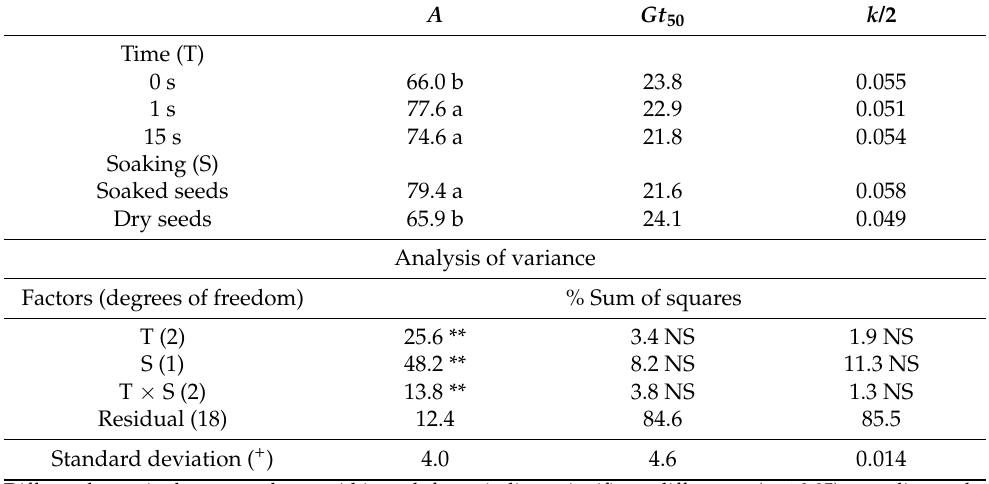
Table 5. Effect of He-Ne laser irradiation during 0, 1 and 15 s applied to dry and soaking the seeds in Different letters in the same column within each factor indicate significant differences ( p ≤ 0.05) water, for 4 days, on the germination parameters: final germination percentage ( A , %), time required to reach 50% of final germination ( Gt 50 ; d), and average germination rate ( k /2; d − 1 ); average values from Experiment 4. A 500 mg L − 1 GA 3 solution was used to wet the substrate.